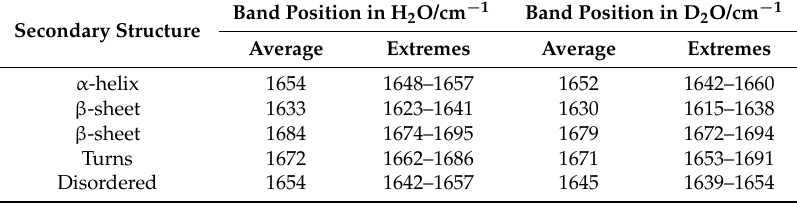
Table 1. Assignment of amide I band positions to secondary structure